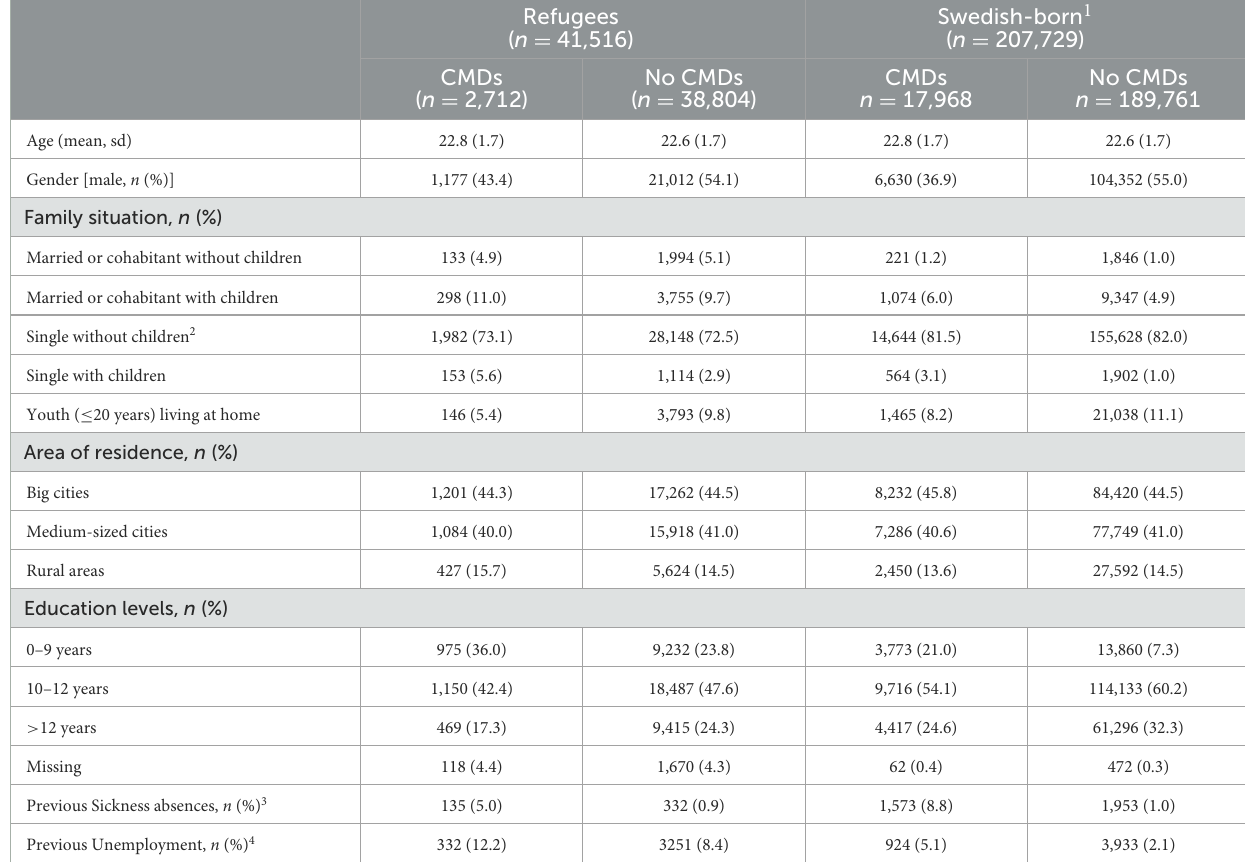
TABLE 1 Baseline characteristics of individuals aged 20–25 years Sweden residents in 2011 ( n = 249,245).